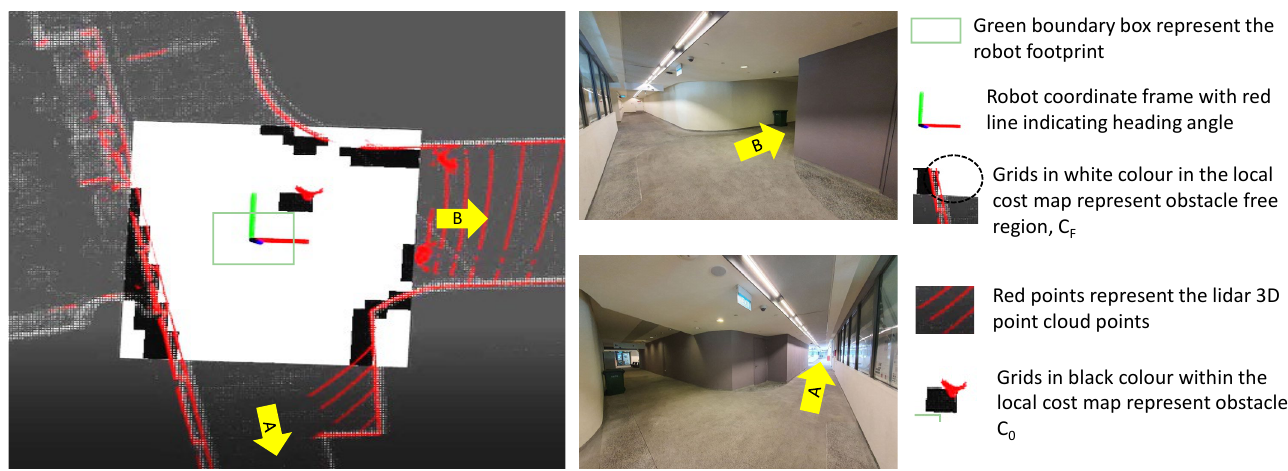
Figure 5. Local Cost Map (the black-colored points map with the obstacle